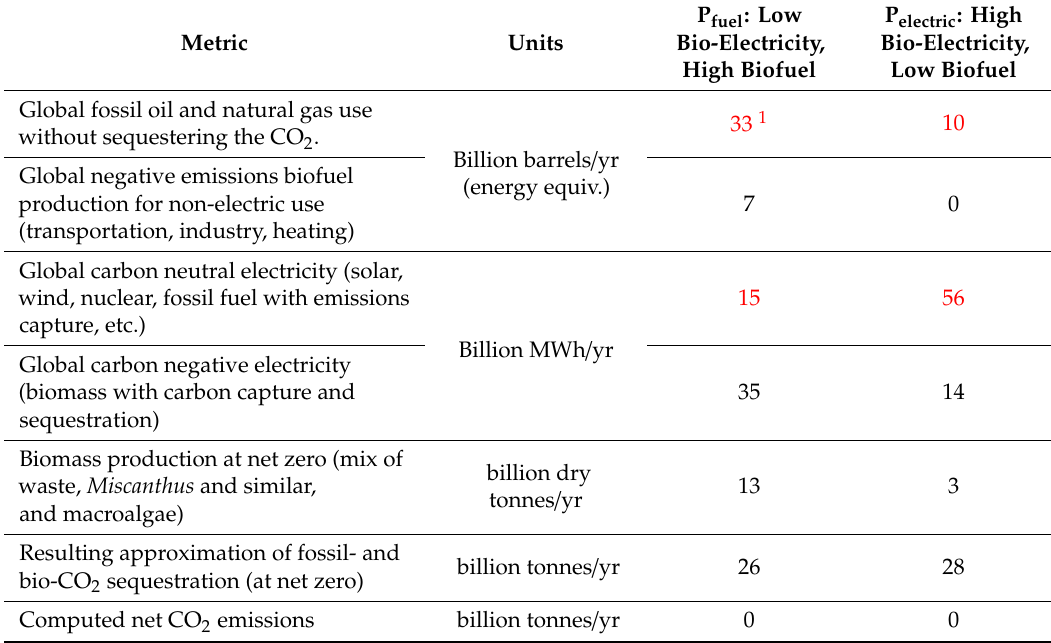
Table 1. Balancing fossil fuel use, biomass-for-energy production, and bio-CO 2 sequestration for net zero emissions about 2050 (from SMS#1). Metric Units